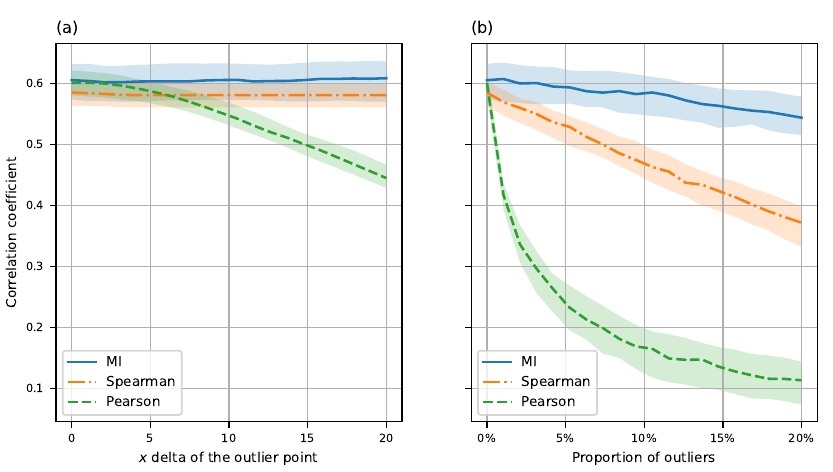
Figure 3. Medians and interquartile ranges of various sample ( n = 500) correlation coefficients ( a ) as the x coordinate of a single point is increased, ( b ) as the proportion of points with x = 10 is increased. It is evident that Pearson correlation is not robust in either case, whereas Spearman and MI correlation are not affected by the single diverging point, and MI is the least affected by either